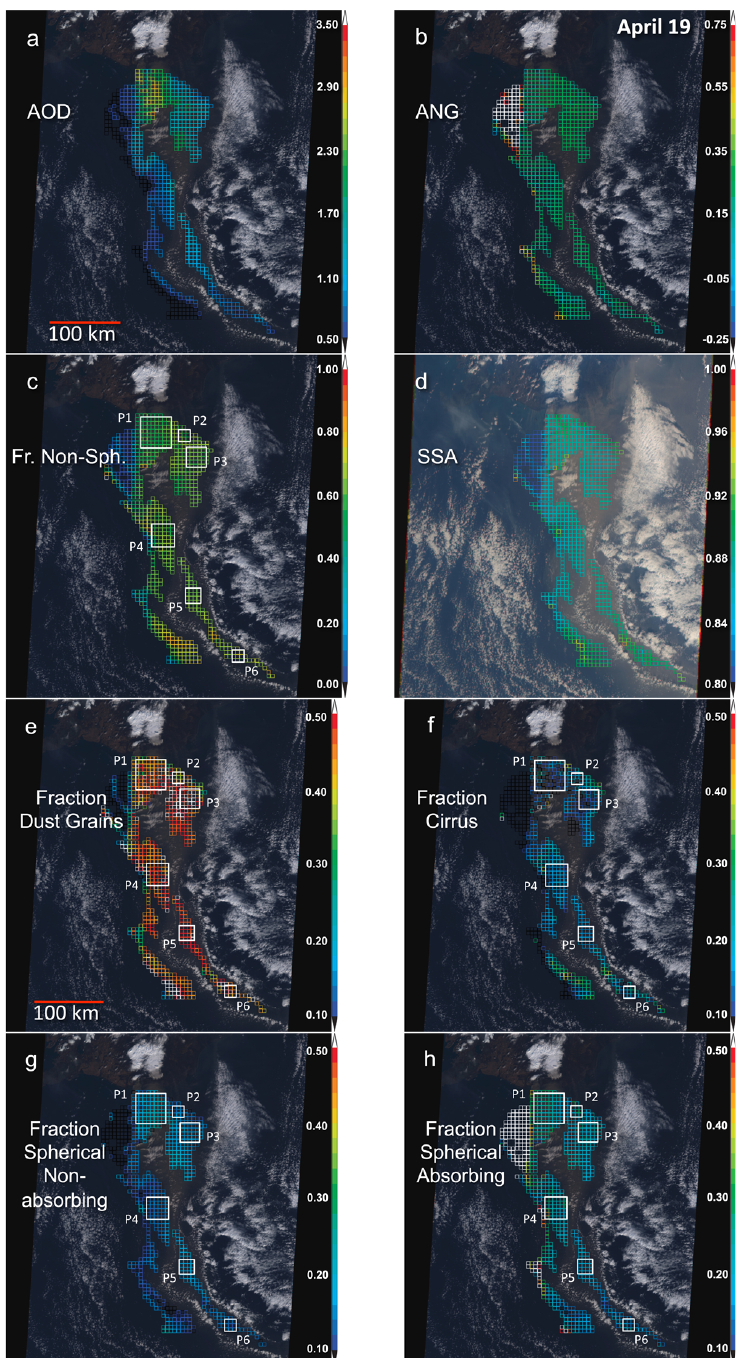
Fig. 5. Same as Fig. 3, but showing results for the 19 April 2010 plume. The volcano is in the top center of these images, and north is roughly toward the top. The multi-angle images were co-registered to the approximate plume elevation of 3km, and the surface wind speed was set to 10ms − 1 . In this case, five MISR cameras were used consistently over the entire retrieval region, to avoid artifacts caused by an increased number of view angles in areas where fewer cameras would have been eliminated by the standard glint mask. The χ 2 patches in this image was set at p min + 0 .